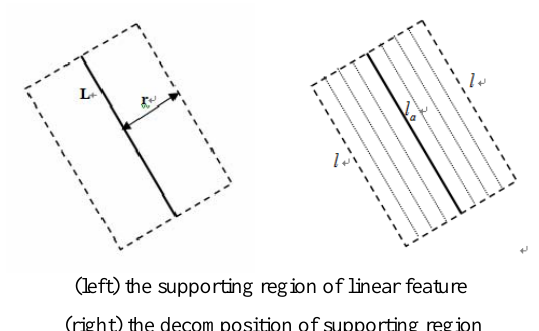
(left) the supporting region of linear feature (right) the decomposition of supporting region Figure 4. Linear feature supporting region and decomposition